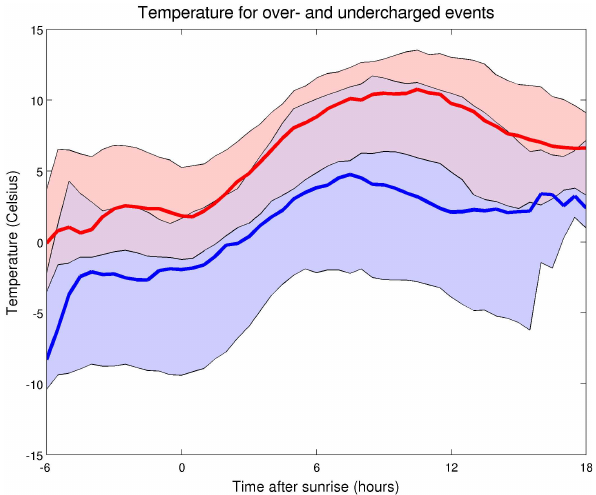
Fig. 3a. The median temperature for all overcharged days (in red) and undercharged days (in blue) excluding summer months. The filled areas represent the 25th to 75th percentiles. The tempera- ture difference excluding summer months is still around 5 degrees Celsius, with warmer temperatures for overcharged days. When all the data points are included, the temperature difference increases to about 8.5 degrees Celsius.